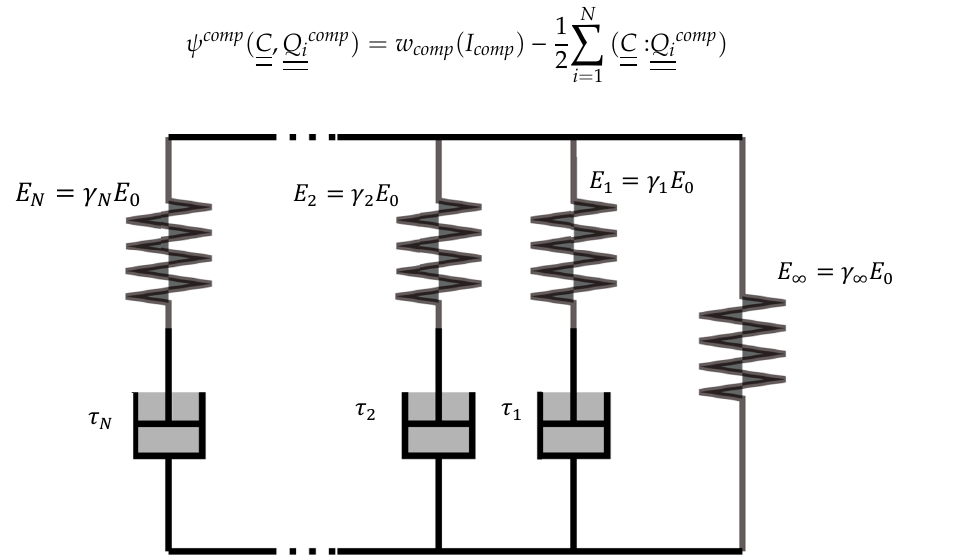
Figure 3. Viscoelastic model with springs and dashpots.